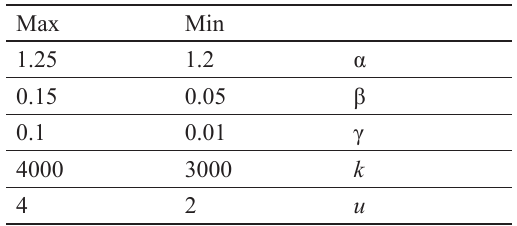
Table 7. Key parameters for sensitivity